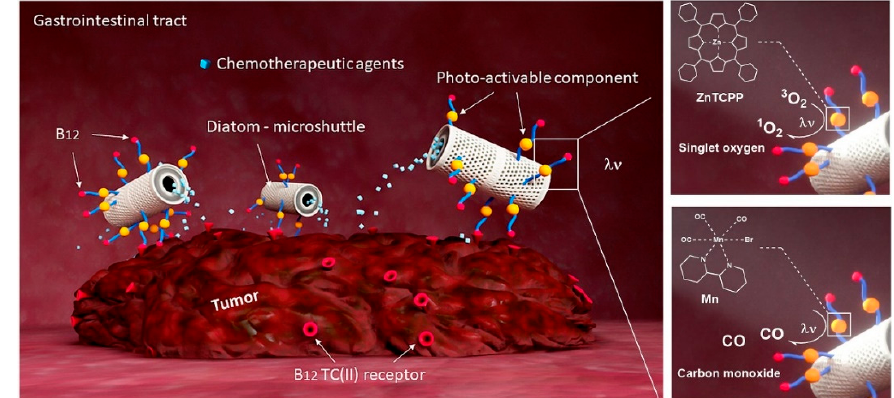
Figure 1. Left. Concept showing the bio-inspired hybrid multifunctional drug delivery system described in this study. Natural diatom microalgae (DEMs) are functionalized at their surface with photoactivatable elements (orange spheres) linked to vitamin B 12 (red spheres) acting as the outer tumor-targeting layer. The construct can be loaded with a chemotherapeutic drug (light blue squares) to be selectively delivered to the tumor site in the intestinal tract. Once DEMs are bound to the tumor mass, the chemotherapeutic drug is slowly released. In addition to that, the micro-capsules can be photoactivated to generate a toxic CO or 1 O 2 , sensitizing the tumor to the treatment. Right. Photo-induced chemical reactions at the surface of the diatom microalgae ( vide infra for more details). For this purpose, two complex bio-vehicles were synthetized. In both cases, the outer layer of the microalgae was still composed of cobalamin (vitamin B 12 , red spheres in Figure 1). The inner